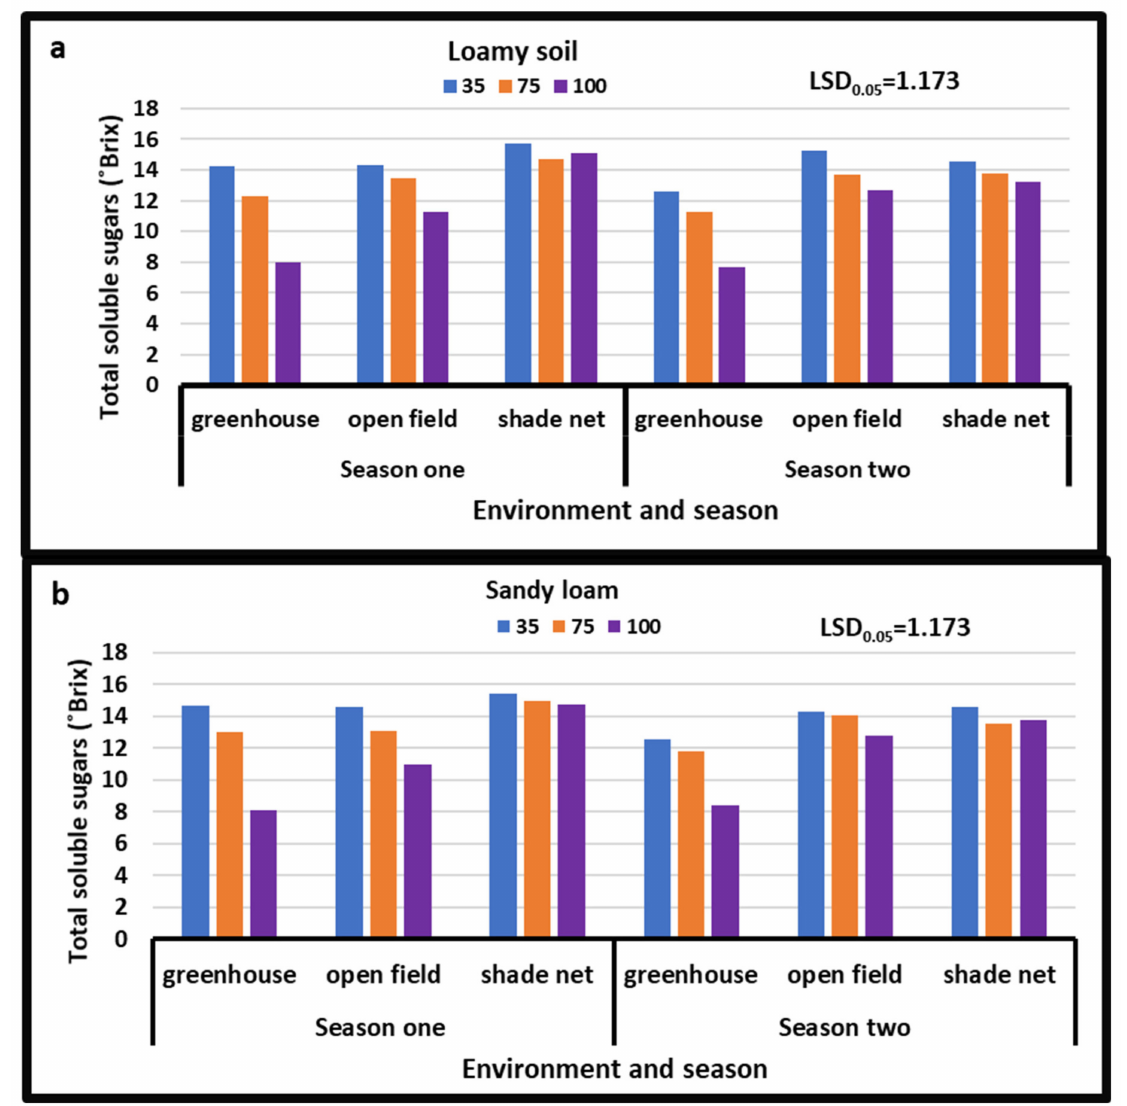
Figure 1. Treatment effect on the total soluble sugars content of African horned cucumber fruit grown in different environments; ( a ) effect of different water stress levels and loamy soil, in different environments, during different seasons (2017/18, season one; and 2018/19, season two); ( b ) effect of different water stress levels and sandy loam, in different environments, during different seasons (2017/18, season one; and 2018/2019, season two); 35 means severe water stress, 75 means moderate water stress, and 100 means no water stress (control). LSD 0.05 is the least significant difference of